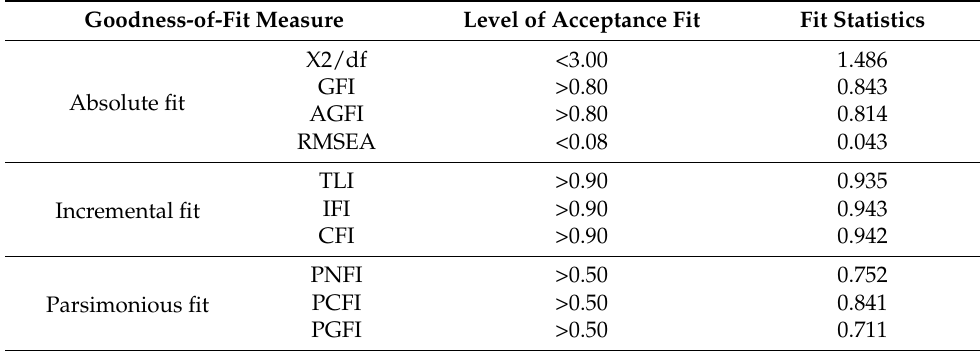
Table 7. Goodness-of-fit of the final structural model. Goodness-of-Fit Measure Level of Acceptance